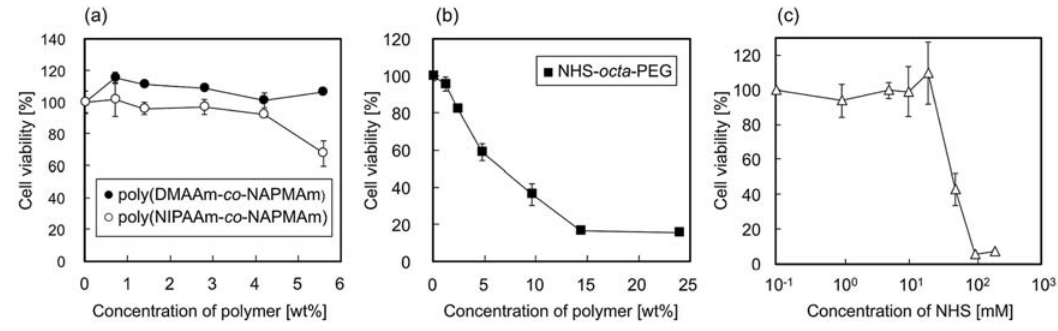
Figure 3. Relative viability of hbmMSCs exposed to ( a ) poly(DMAAm ‐ co ‐ NAPMAm) and poly(NIPAAm ‐ co ‐ NAPMAm), ( b ) NHS ‐ octa ‐ PEG, and ( c ) NHS for 18 h at 37 °C, compared to that of cells without exposure. Data are expressed as the means of triplicate measurements (± standard